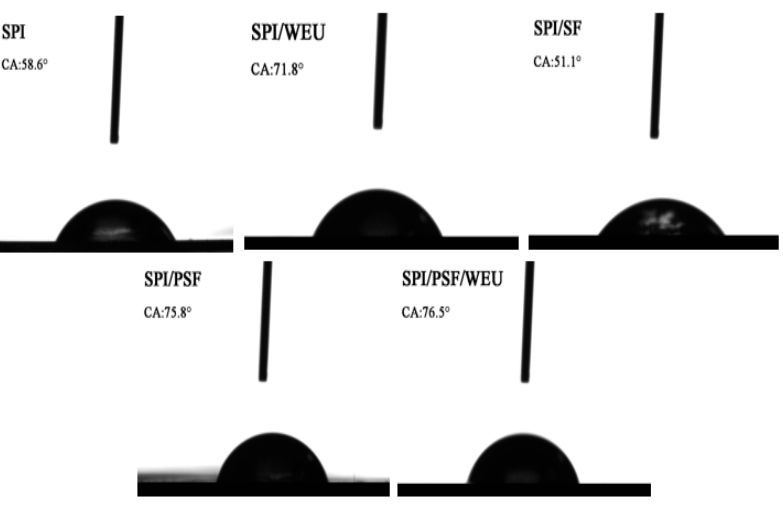
Figure 9. The water contact angle (WCA) of neat SPI, SPI/WEU, SPI/SF, SPI/PSF, and SPI/PSF/WEU films.